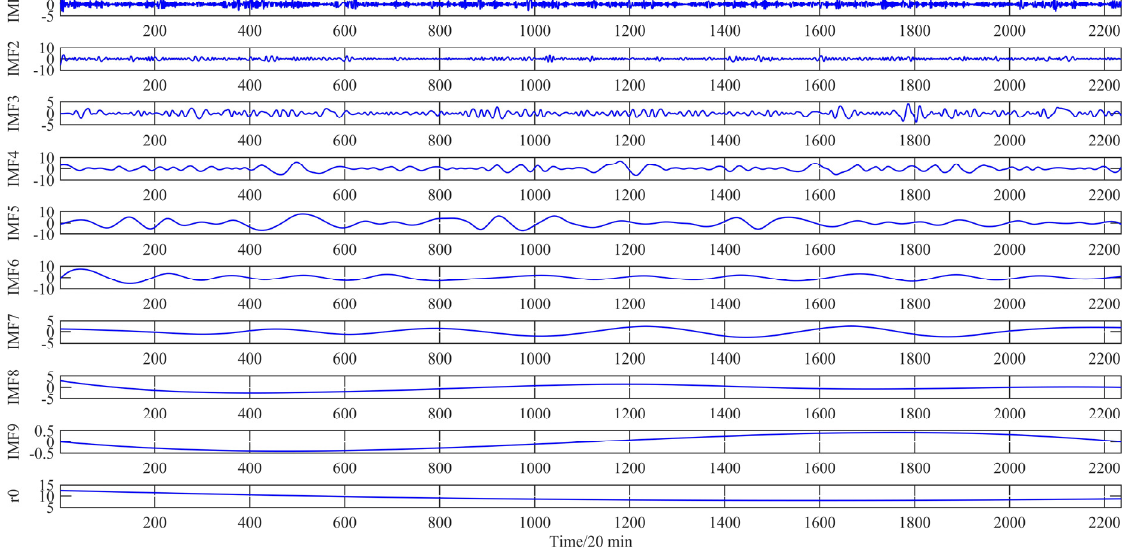
Figure 5. The decomposition of the wind speed during the period from 1 January to 31 January 2011 by